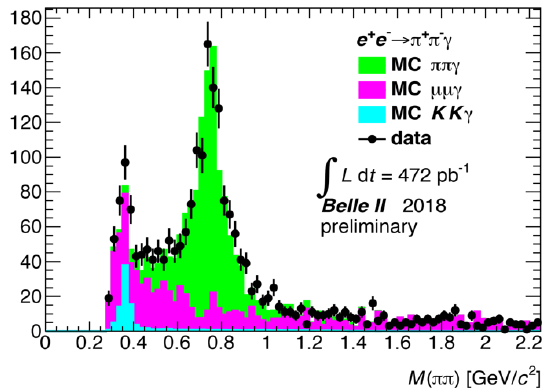
Figure 10: Study of the processes from ISR at Belle